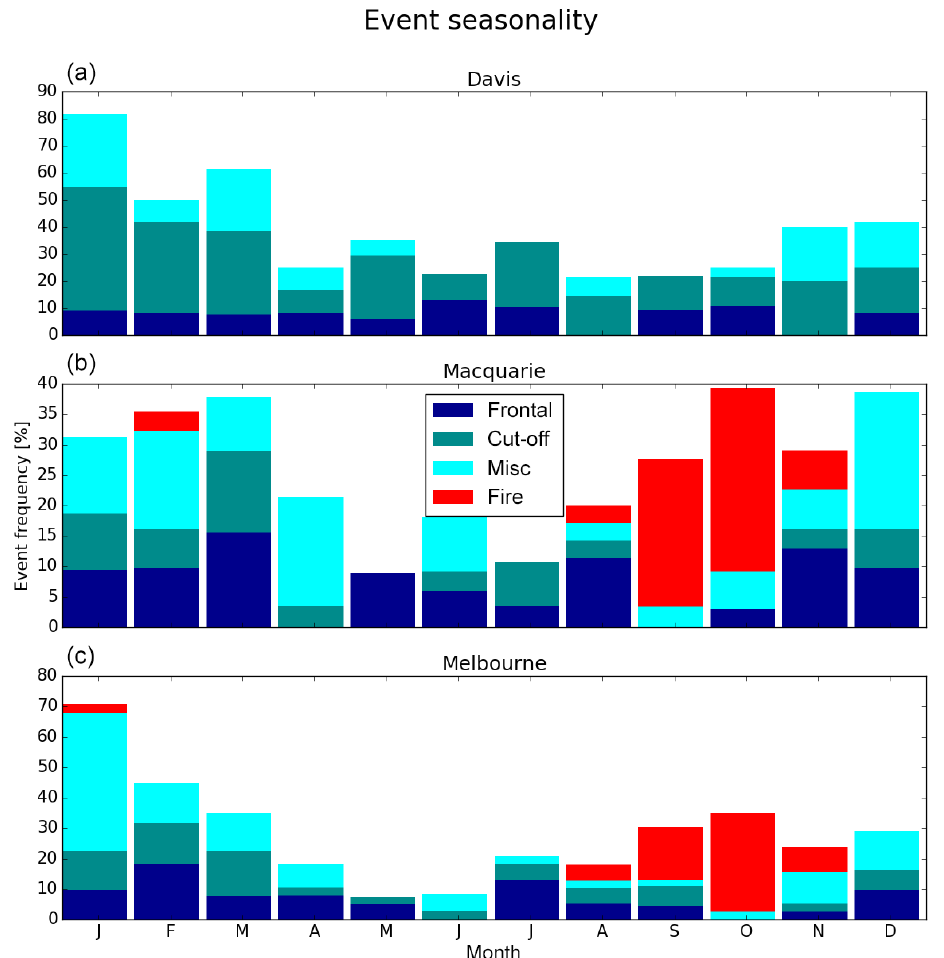
Figure 5. Seasonal cycle of STT event frequency at Davis (a) , Macquarie Island (b) , and Melbourne (c) . Events are categorised by associated meteorological conditions as described in the text, with low-pressure fronts (“frontal”) in dark blue, cut-off low-pressure systems (“cut-off”) in teal, and indeterminate meteorology (“misc”) in cyan. Events that may have been influenced by transported smoke plumes are shown in red (see text for